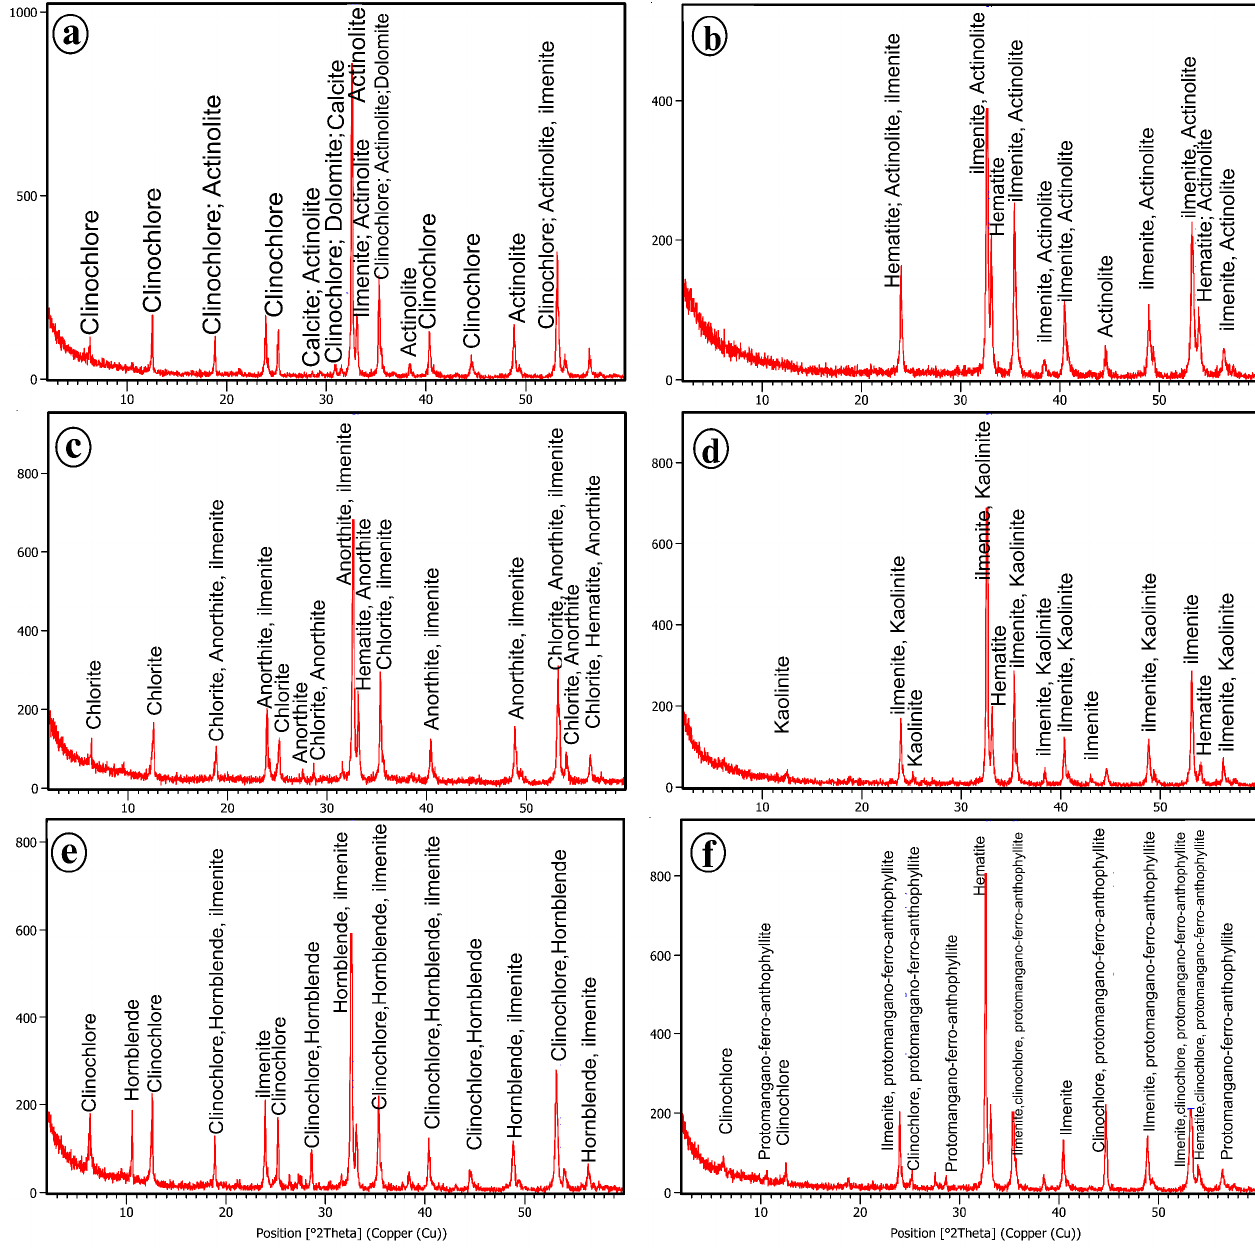
Figure 8. XDR patterns of Fe-Ti oxides bearing gabbroic rocks showing the following minerals: ( a ) chlinochlore, actinolite, calcite, dolomite; ( b ) hematite, ilmenite, actinolite; ( c ) chlorite, anorthite, ilmenite, hematite; ( d ) kaolinite, ilmenite, hematite; ( e ) clinochlore, hornblende, ilmenite; ( f ) clinochlore, ilmenite, hematite, protomangano-ferro-anthophyllite.